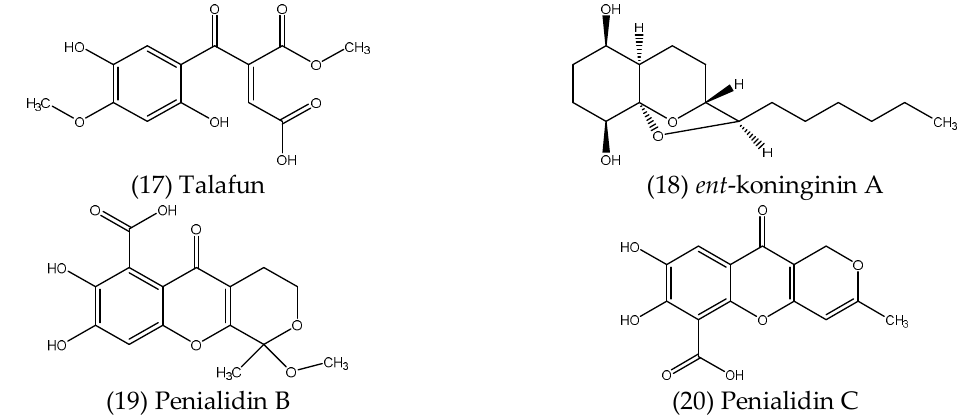
Figure 5. Structures of antimicrobial polyketides isolated from endophytes.